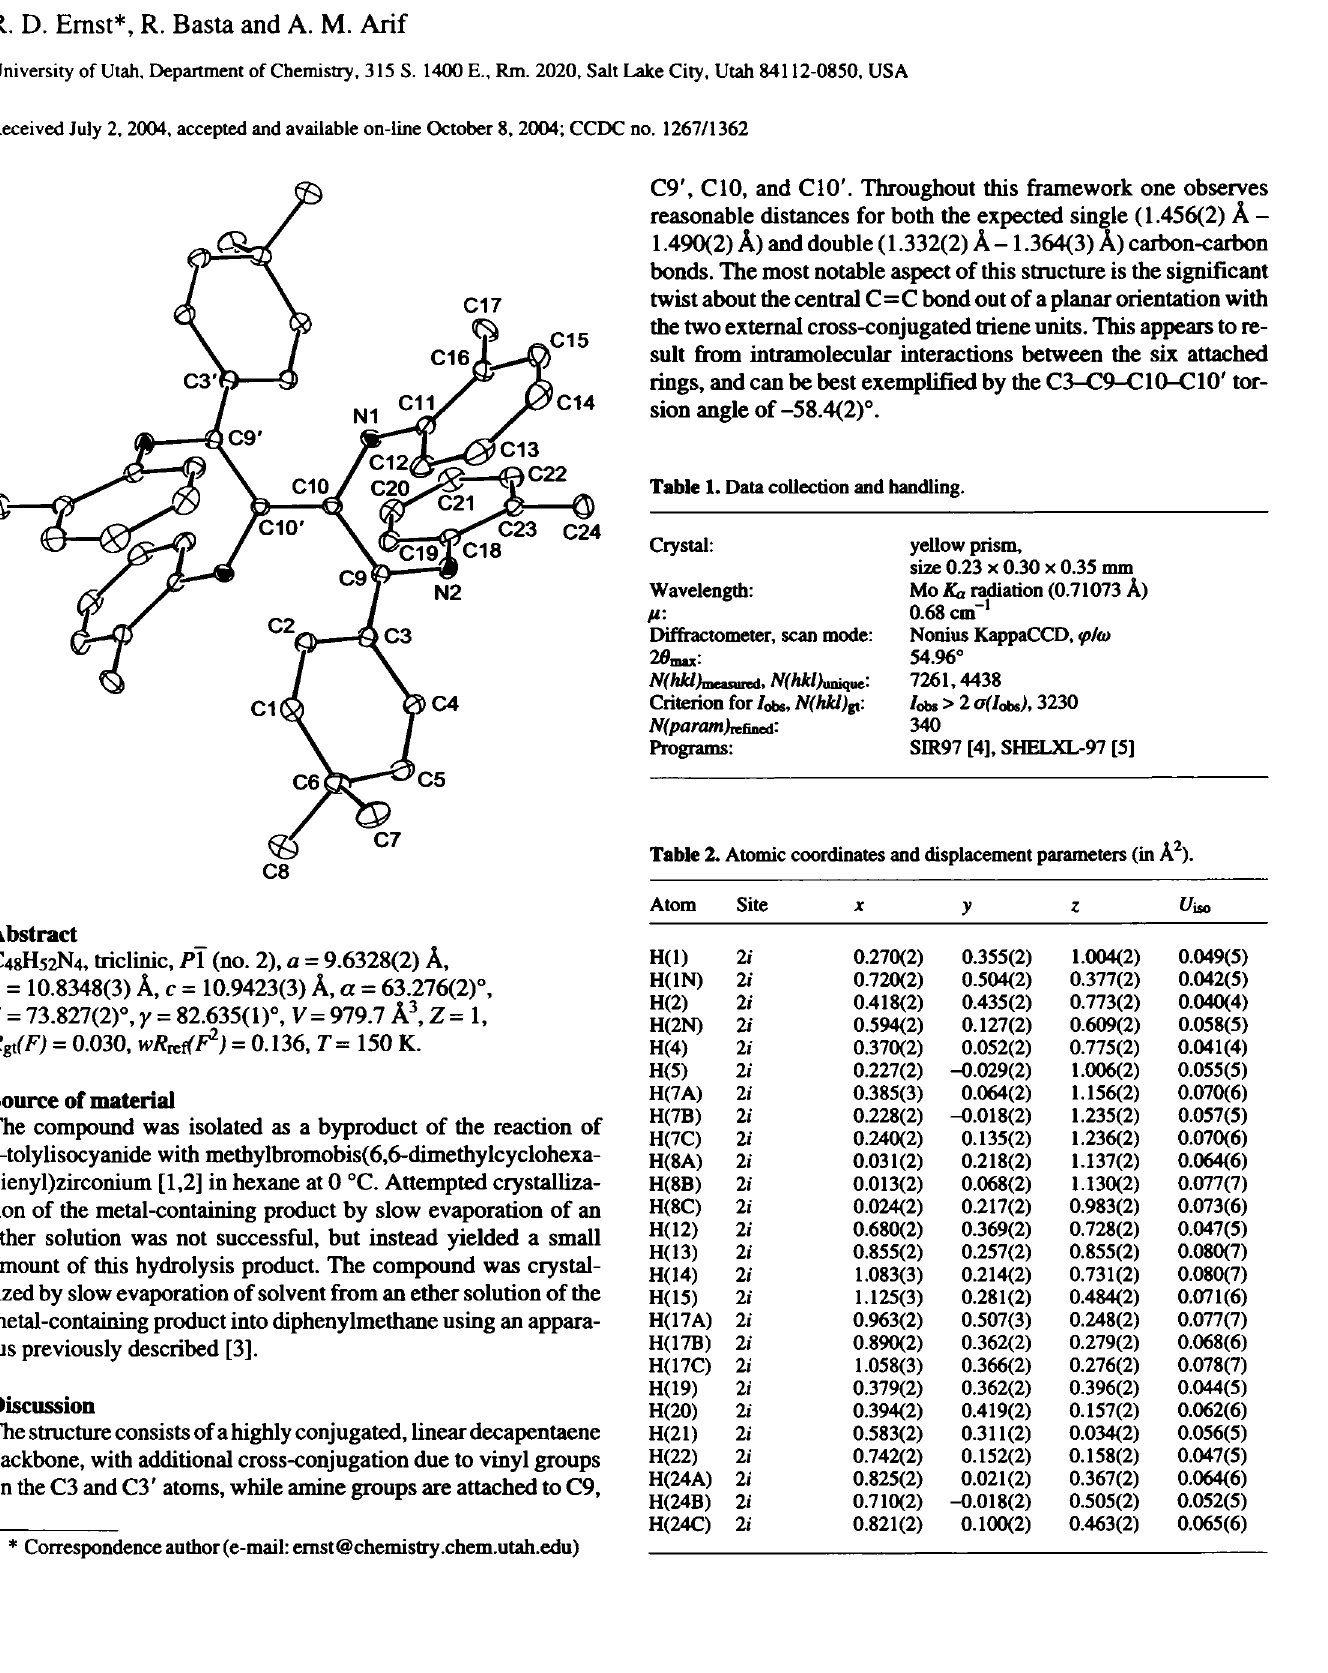
Table 2. Atomic coordinates and displacement parameters (in Â 2